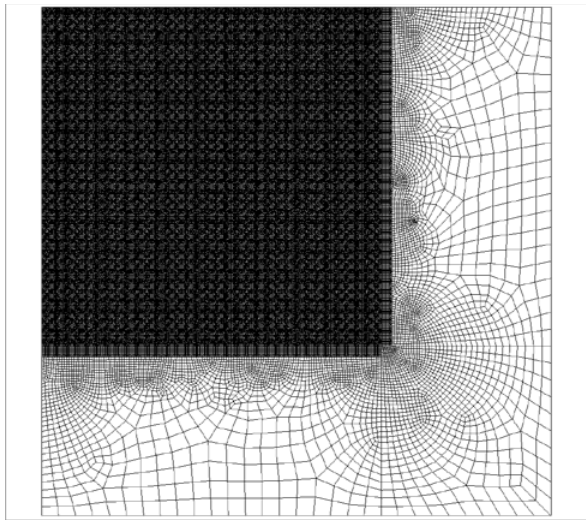
Figure 2. Mesh Composition of the Whole Reactor (X-Y,